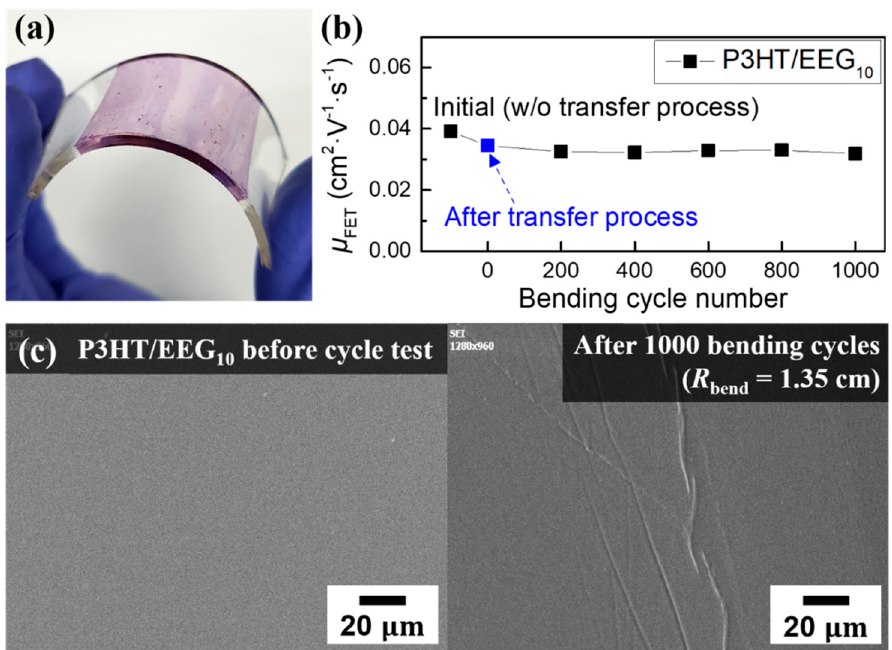
Figure 8. ( a ) Photo image of the P3HT/EEG 10 nanocomposite film with the Poly(dimethylsiloxane) (PDMS)/PEDOT:PSS substrate under bending condition ( R bend = 1.35 cm). ( b ) Change of the field-effect mobility depending on the bending cycles. ( c ) SEM images of the P3HT/EEG 10 nanocomposite film before (left) and after (right) cyclic bending test.